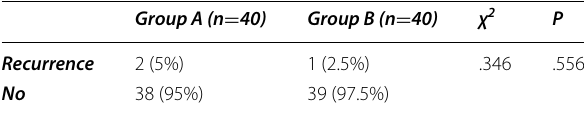
Table 5 Postoperative recurrence between the two studied